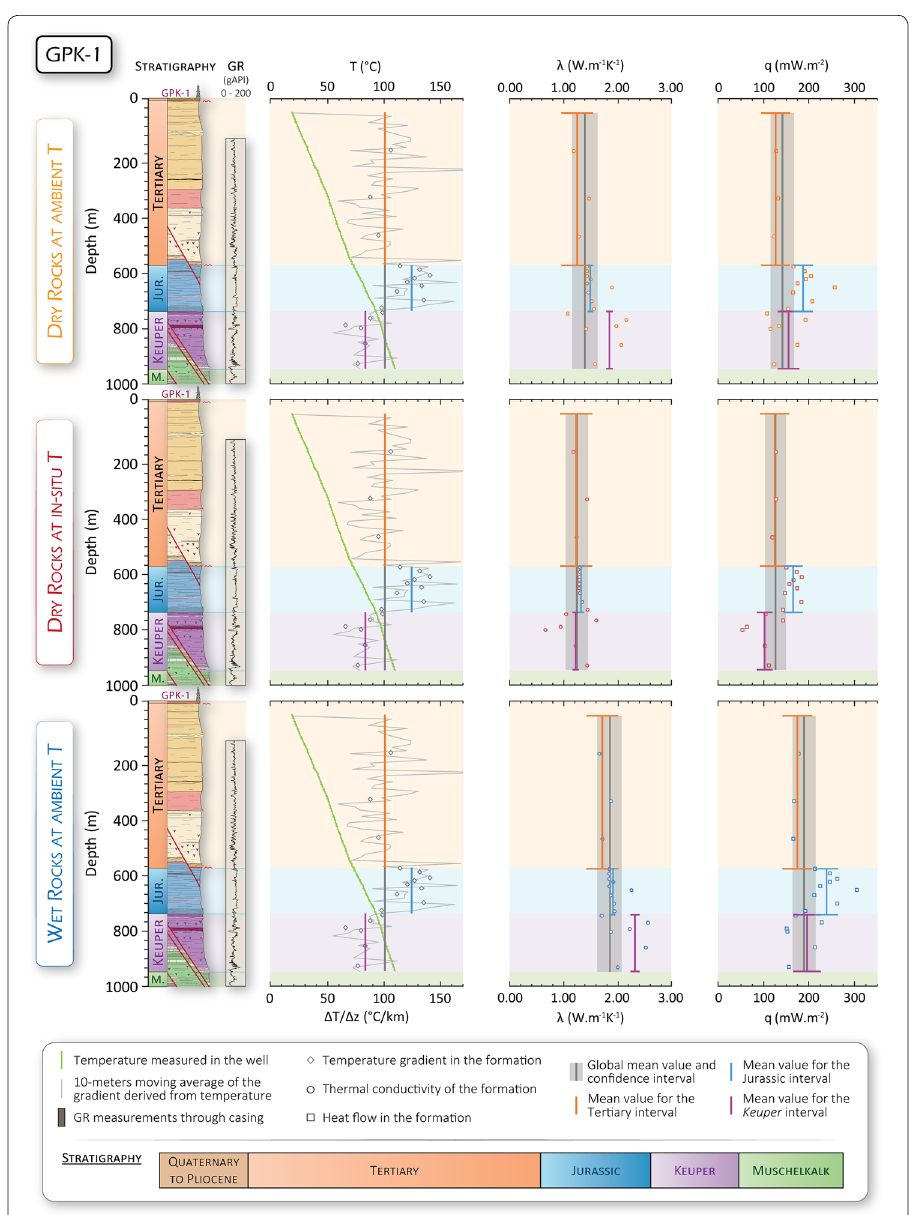
Fig. 10 Stratigraphic log and gamma ray (GR) (after Aichholzer et al. 2016), measured temperature profile T and derived temperature gradient ∆ T /∆ z (same scale as temperature profile), thermal conductivities λ for dry, hot and wet formations and associated calculated heat flow densities q for the Soultz-sous-Forêts GPK-1 well. Vertical lines indicate mean values for ∆ T /∆ z (left), λ (middle) and q (right) for a given interval (global (from surface to top of the Muschelkalk), Tertiary, Jurassic and Keuper). Dots indicate average value for a given formation. Stratigraphy is shown in the background for each